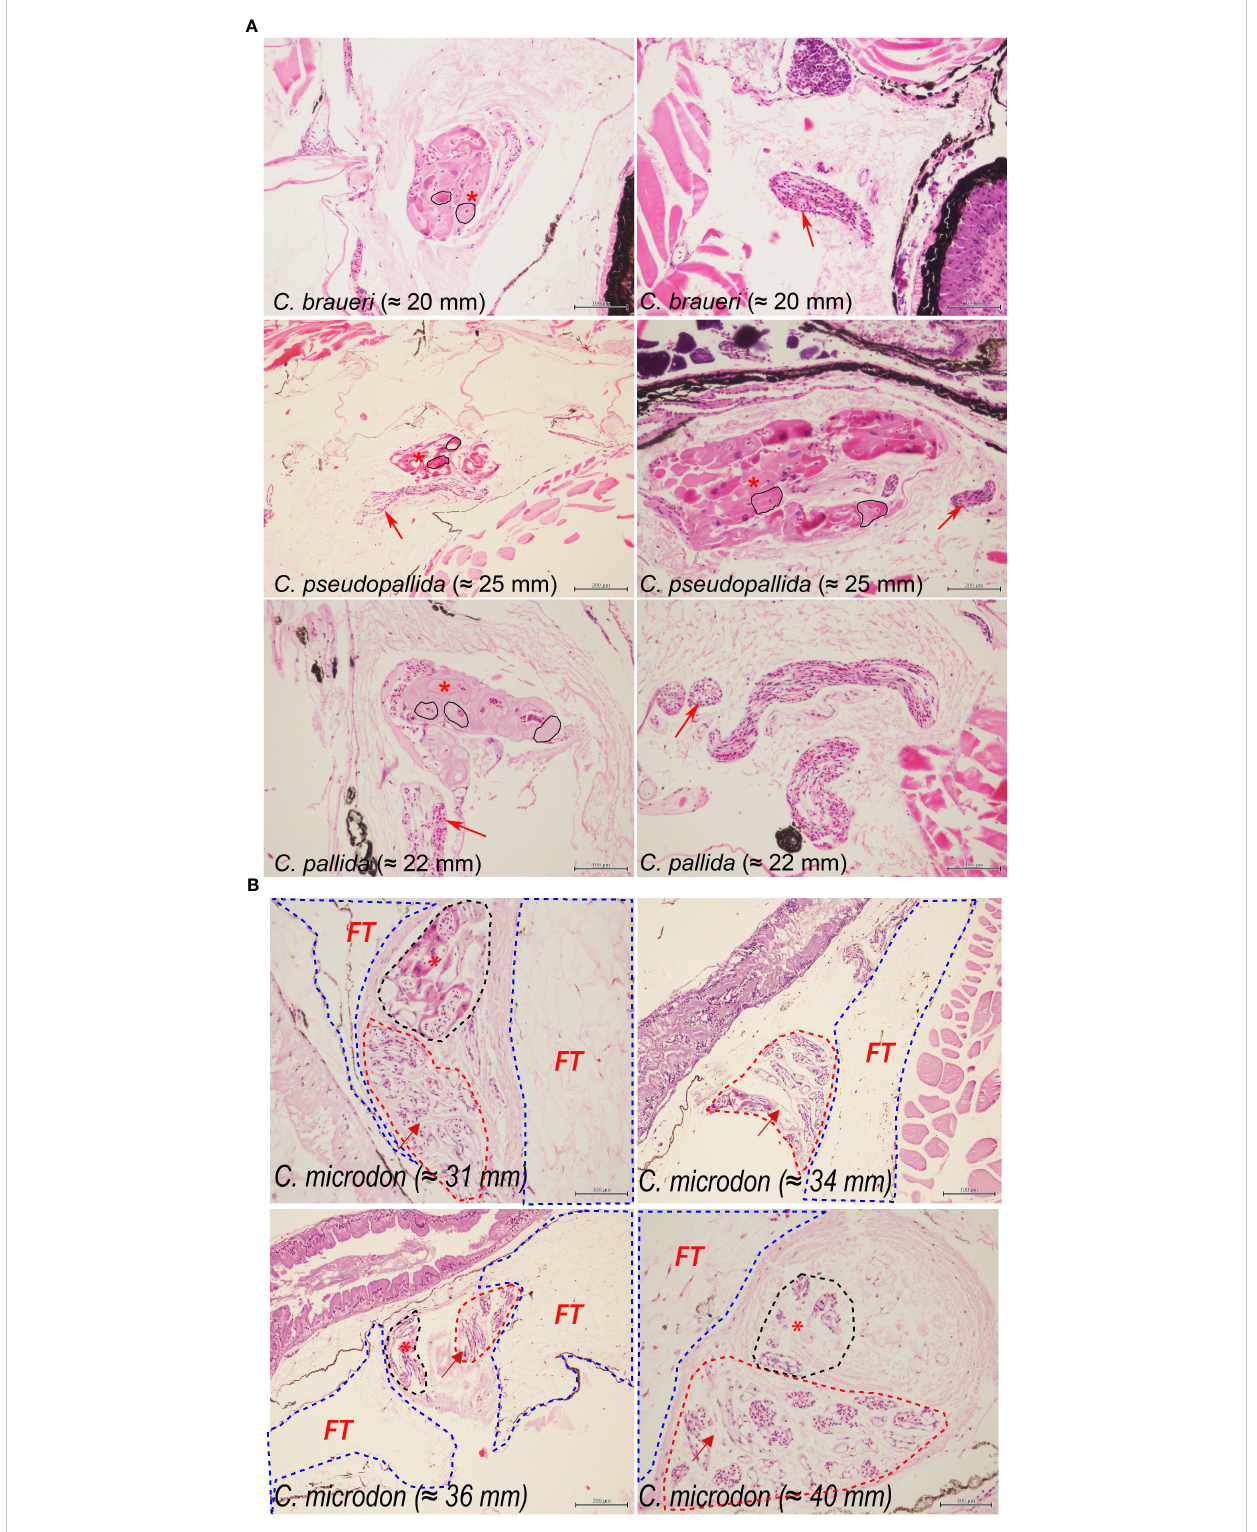
FIGURE 7 (A) Histological sections of C. braueri (20 mm ), C. pseudopallida (25 and 19 mm), and C. pallida (19 mm ). The asterisk indicates the Gas gland, and the arrow indicates the rete mirabile . The black contour delineates the area of gas gland. * C. braueri and C. pallida panels show different sections of the same individual. (B) Histological sections of C. microdon individuals. The asterisk indicates the Gas gland, and the arrow indicates the rete mirabile . The blue contour delineates the fat tissue, the red contour the rete mirabile, and the black contour the gas